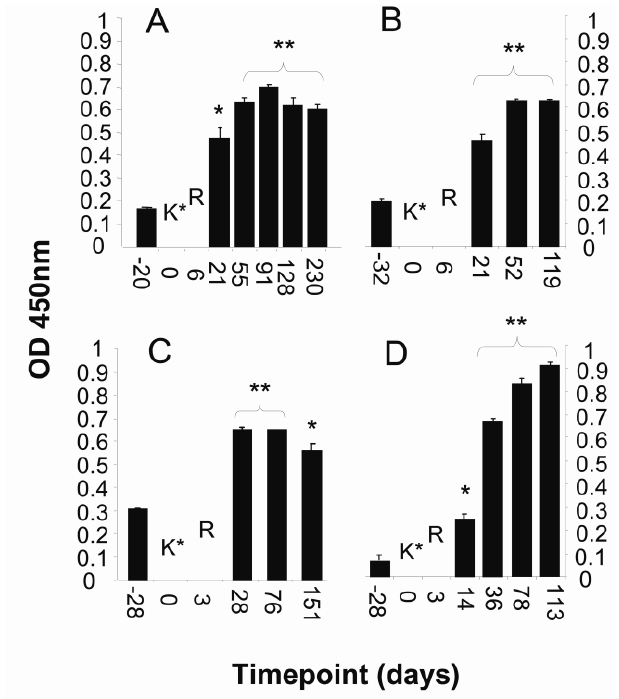
Figure 4. Serum levels of anti-KLH antibody relative to treatment sequence. Representative data from patients with cancer of the ( A ) breast; ( B ) ovary; ( C ) stomach; and ( D ) lung. Anti-KLH assessed by ELISA in serum samples obtained before and after treatment. KLH administration occurred at timepoint 0 and is denoted by K*; R indicates the time at which the immunization sites were irradiated. Significant increases in anti-KLH antibody levels following treatment are indicated by double ( p < 0.005) and single ( p < 0.05)